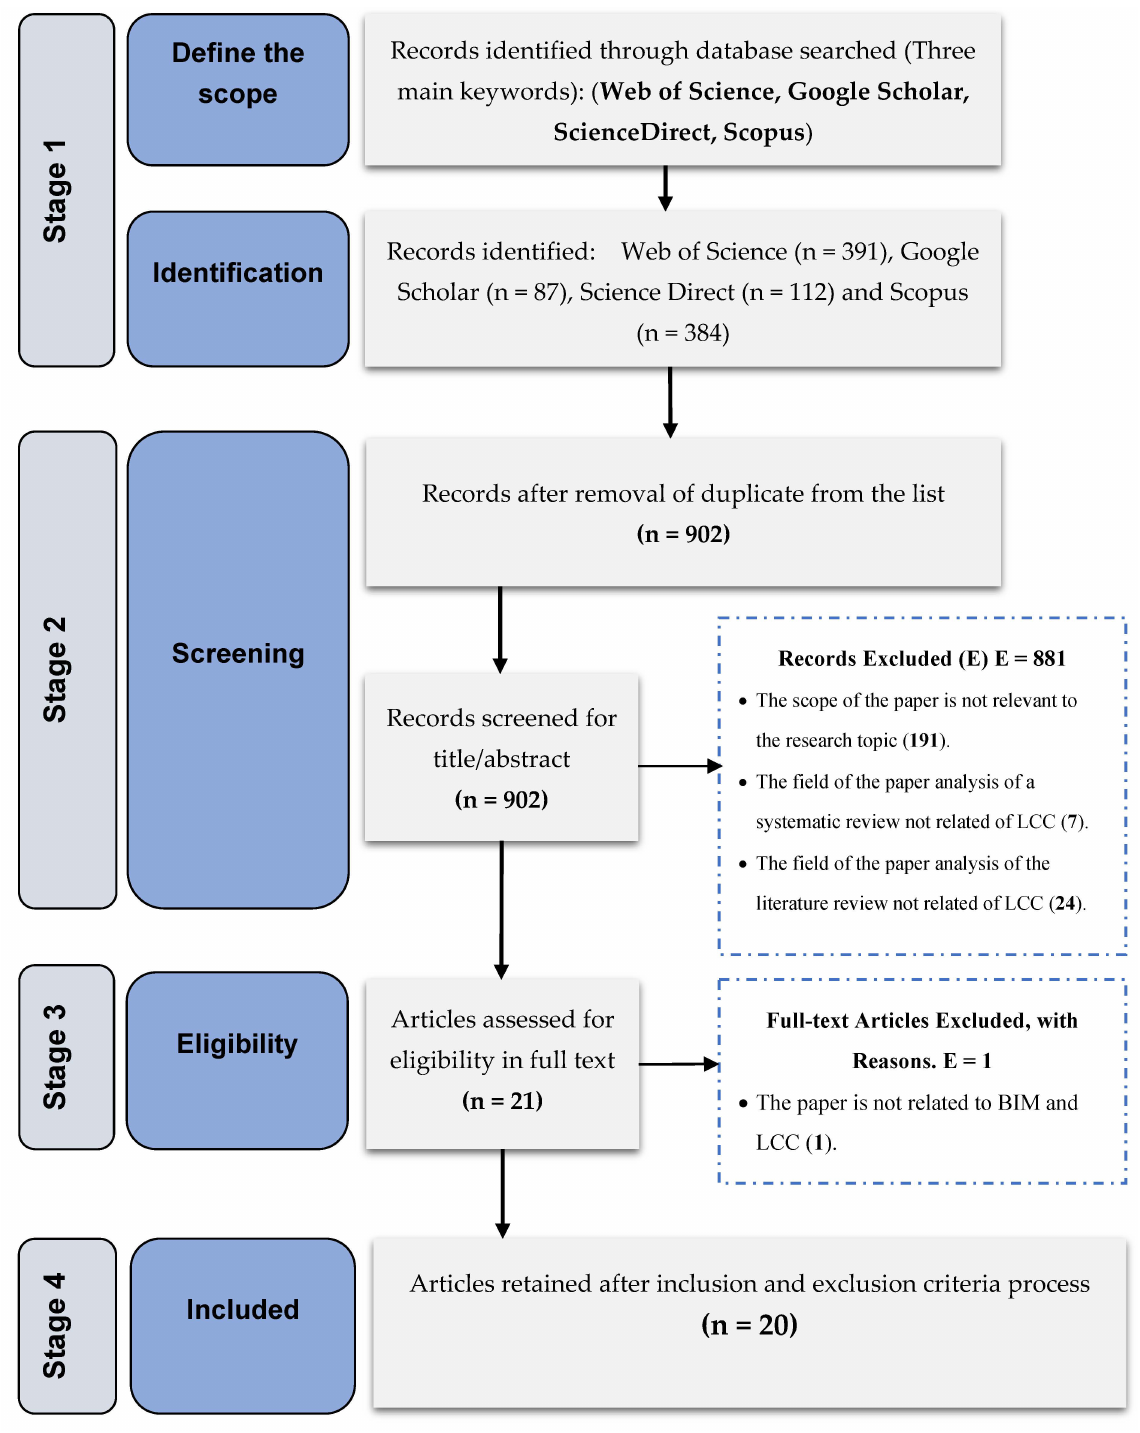
Figure 3. The details of the flow-chart of the systematic review process (PRISMA). The findings indicate that 2.05% of articles were approved through the database. The